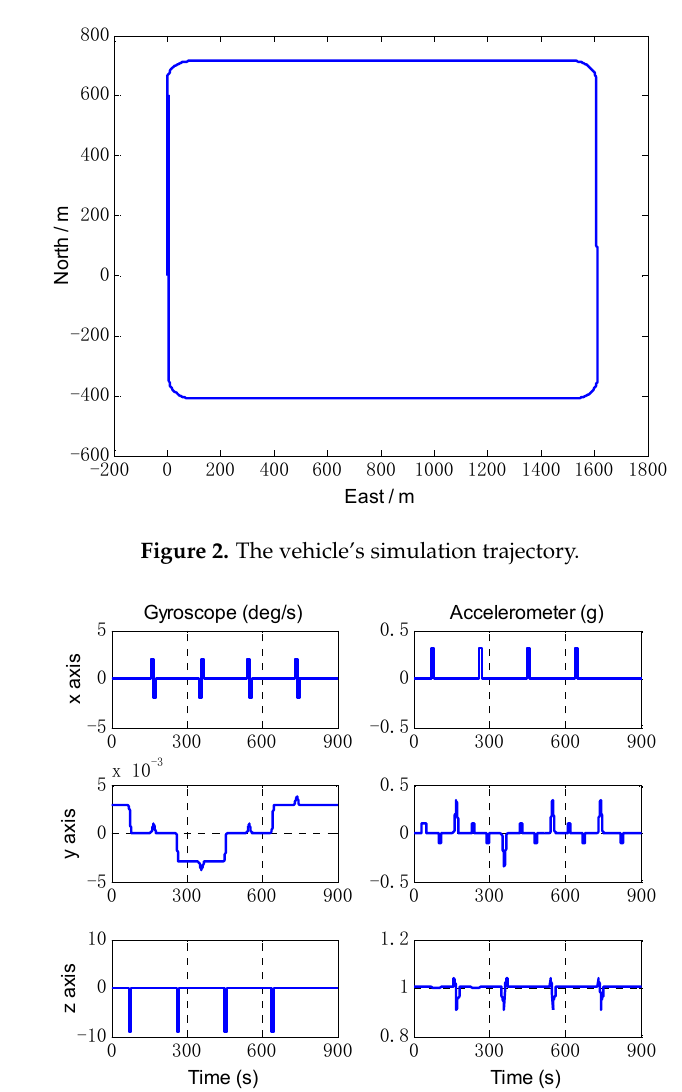
Figure 3. The IMU data of typical motions simulation. The left three figures are the angular rate measured by gyroscopes, the right three figures are the specific forces.